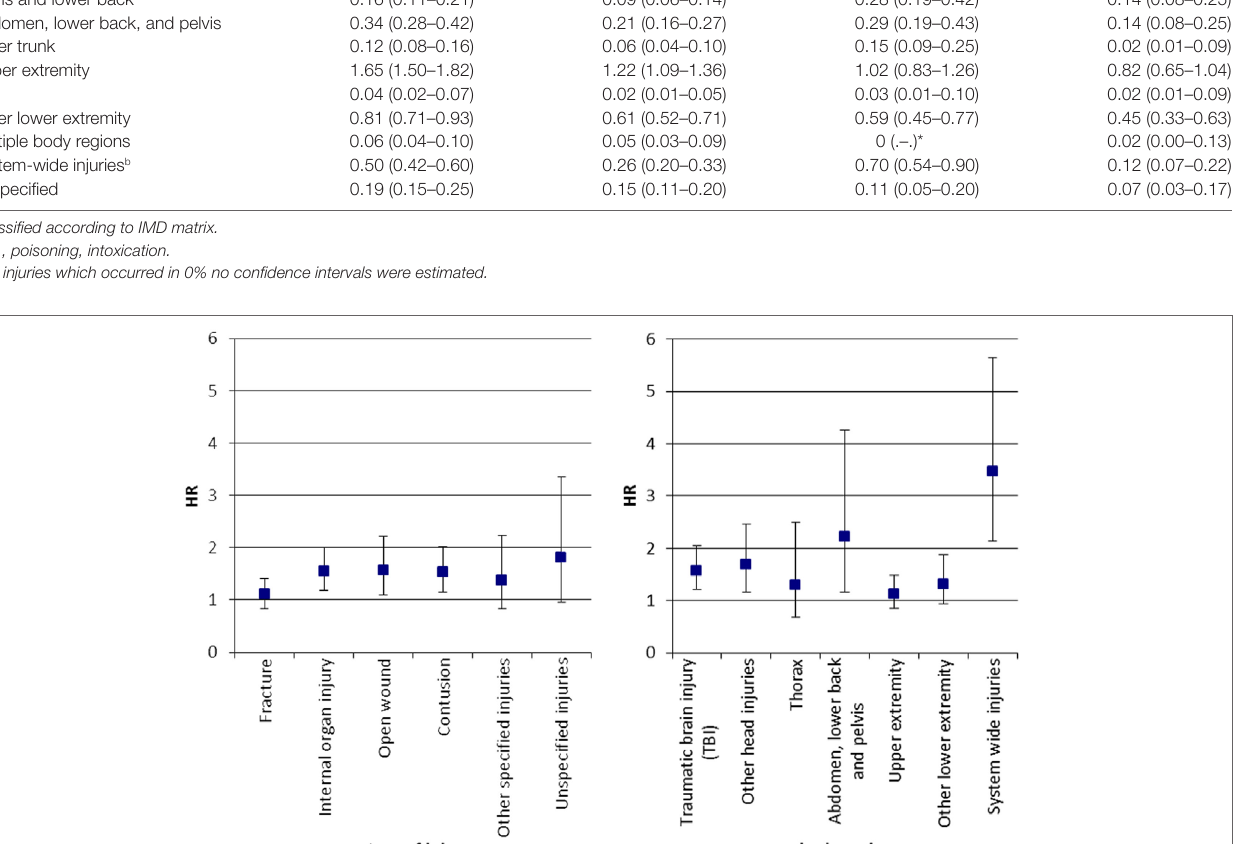
affected body region